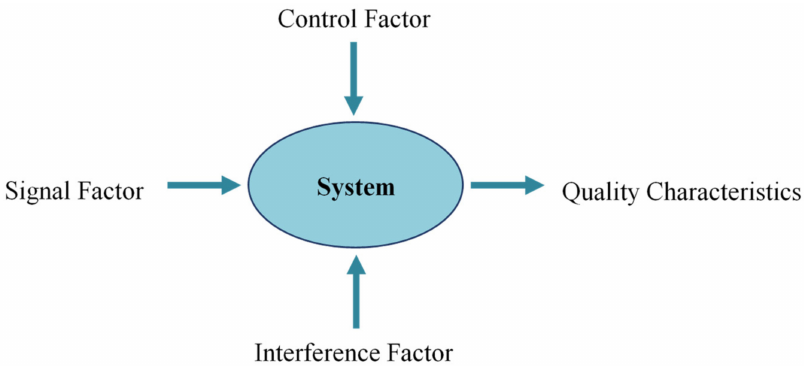
Figure 6. Experimental factors in Taguchi